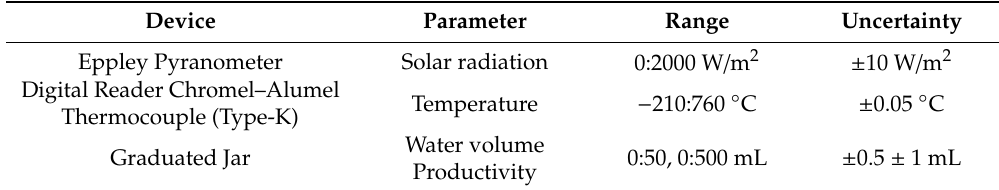
Table 1. Uncertainties of the measured